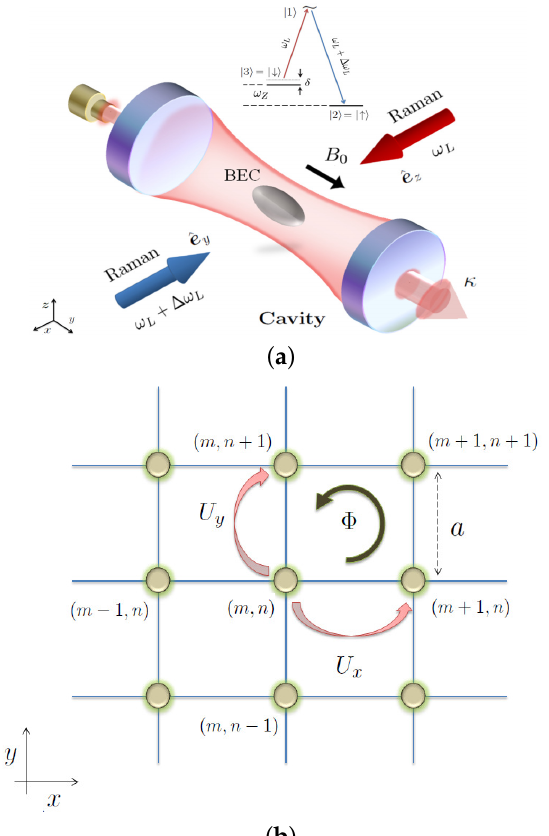
Figure 8. ( a ) 87 Rb BEC inside an optical cavity: spin-orbit coupling (SOC) is created by two counter-propagating Raman lasers with frequencies ω L and ω L + ∆ ω L that are applied along ˆ x . The Raman beams are polarized along ˆ z and ˆ y (gravity is along -ˆ z ). A bias field B 0 is applied along ˆ y to generate the Zeeman shift. (Inset) Level diagram of the 87 Rb atom. Internal states are denoted as | 1 (cid:105) , | 2 (cid:105) , | 3 (cid:105) . The coupling of these states is shown schematically; ( b ) Schematic of an optical lattice. The phase operator U x determines the phase acquired by an atom when it hops from site ( m , n ) to the site ( m + 1, n ) . Similarly, the operator U y determines the phase acquired by hopping along the positive y -axis. The operators U † x and U † y determine the phase acquired in hopping along negative x and y axes, respectively. Figure taken from [34]. (Reprinted figures with permission from Padhi, B.; Ghosh, S. Phys. Rev. A 2014, 90, 023627. Copyright (2014) by the American Physical Society. Source: